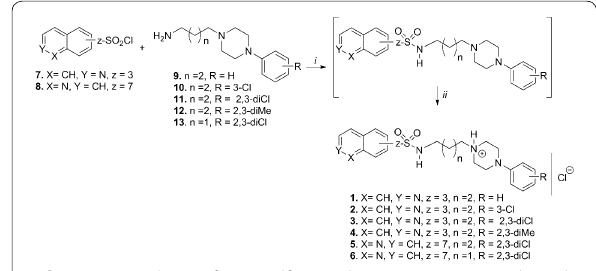
Scheme 1 Synthesis of azinesulfonamides 1 – 6 . Reagents and condi- tions: (i) DIEA, CH 2 Cl 2 , 0 °C/rt.; (ii) 1 M HCl in